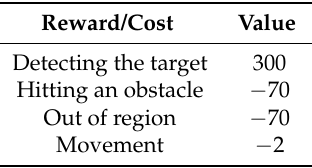
Table 2. Summary of rewards and costs in the UAV navigation